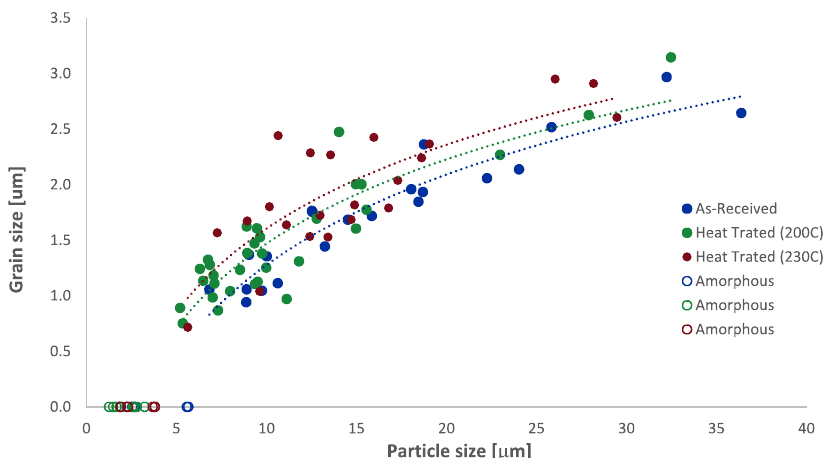
Figure 22. Grain size as a function of particle size for gas-atomized powder in the as-atomized condition and two thermally processed conditions, which were achieved after 24 h of hold time at 200 and 230 °C and labeled as such in the graphs key.